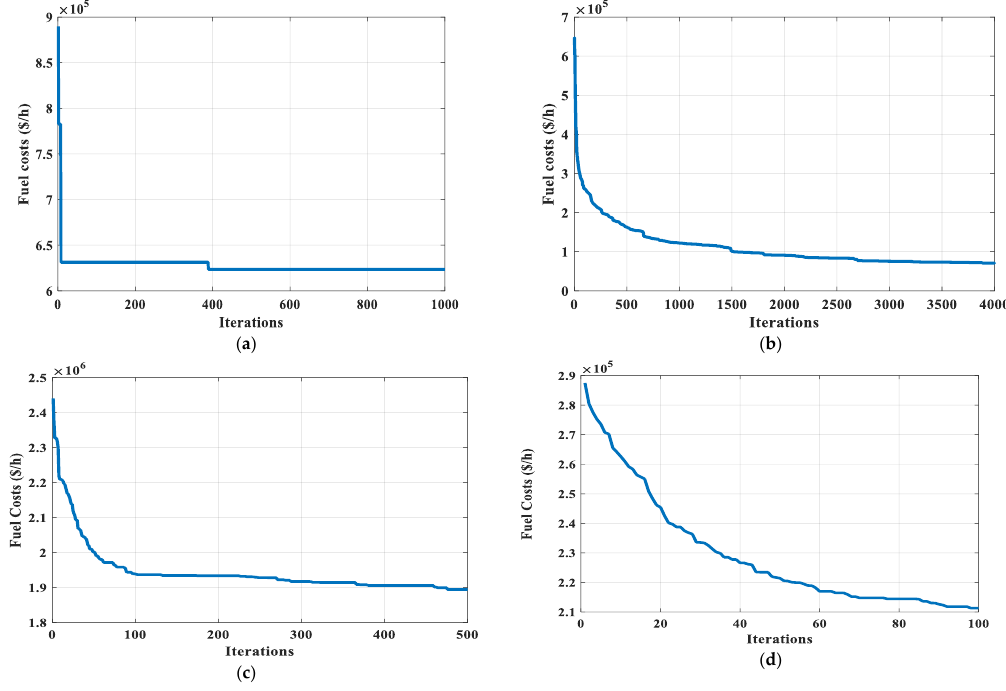
Figure 5. Convergence rates for large scale test systems. ( a ) 300-bus; ( b ) 1354pegase; ( c ) 3012wp; ( d ) 9241pegase. Table 11. TFWO versus recent optimization algorithms for the IEEE large scale test system: Cases 18 – 21.